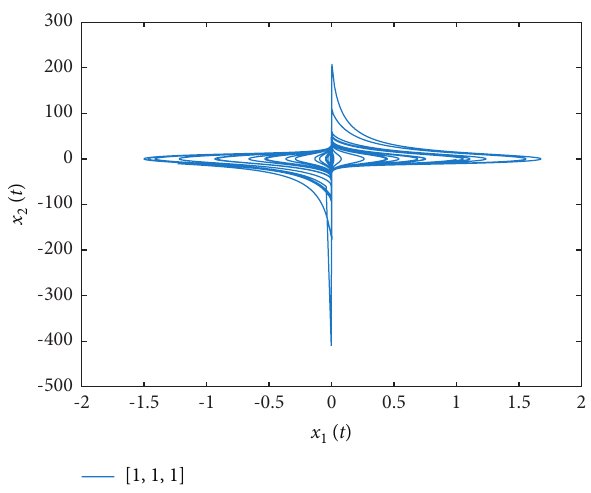
Figure 1: Chaotic phenomenon of integer-order gyro system (21).